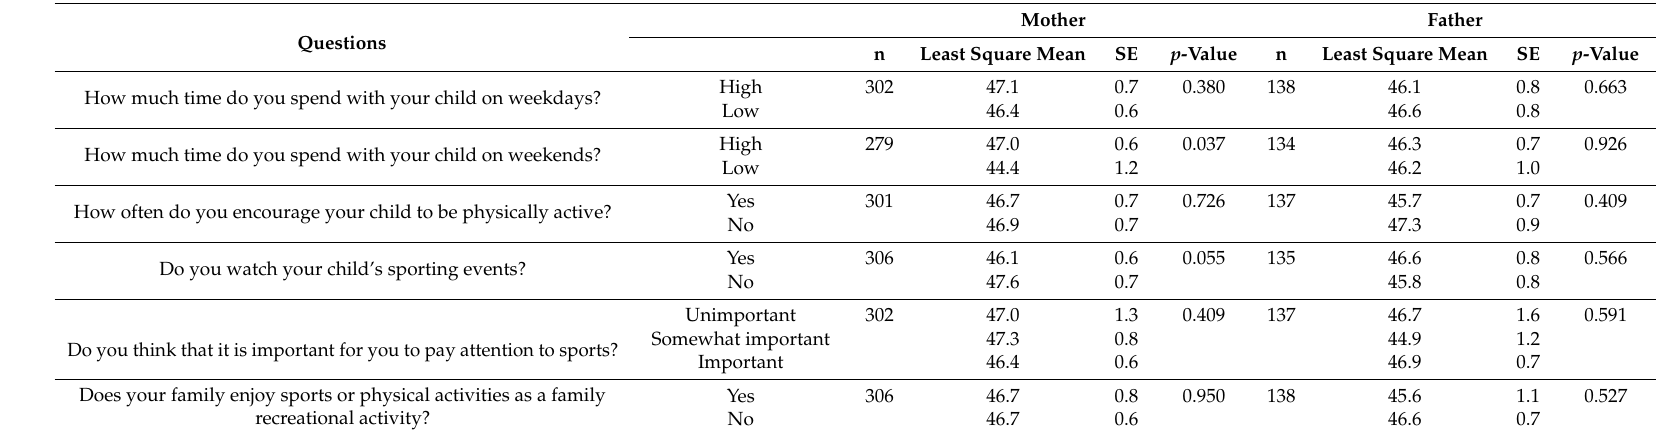
Table 5. Associations between objectively evaluated children’s sedentary time and parental support.